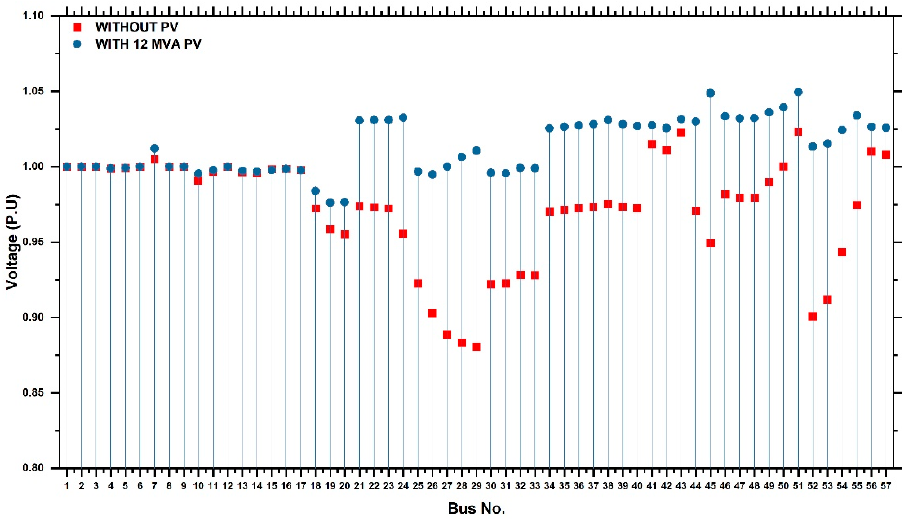
Figure 16. 12 MVA—voltage profile with and without a photovoltaic generator.